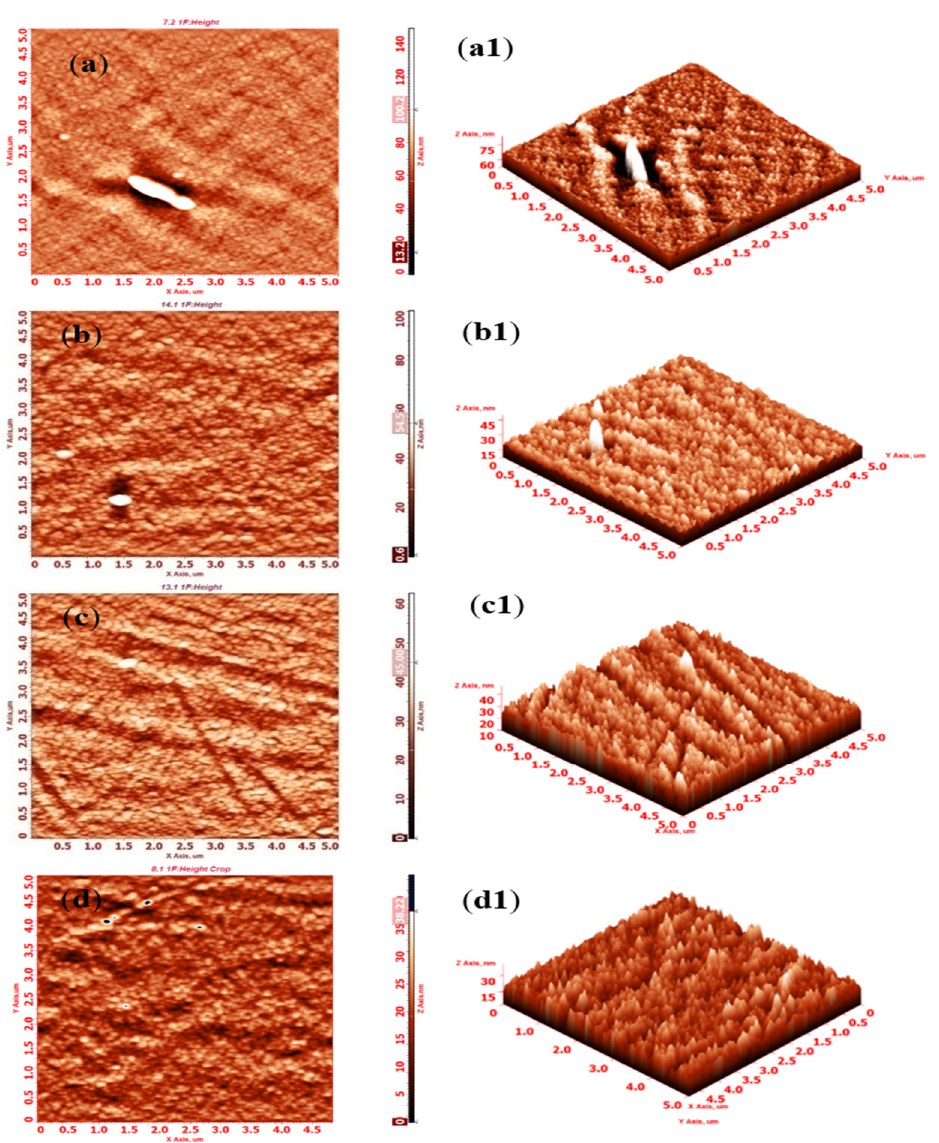
Figure 6. 2D ( a – d ) and 3D ( a1 – d1 ) surface images of control (PSF/Dia 0 . 0 ) and diatomite-incorporated PSF/Di composite membranes by AFM. ( a , a1 ) PSF/Dia 0 . 0 , ( b , b1 ) PSF/Dia 0 . 1 , ( c , c1 ) PSF/Dia 0 . 2 , and ( d , d1 ) PSF/Dia 0 . 5 .